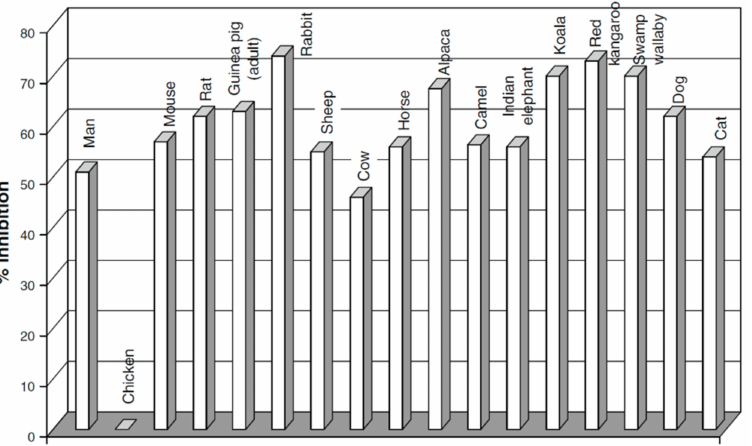
Figure 58. Inhibition of the permeability of RBCs in humans and some laboratory animals and pets for water by PCMBS. Reprinted with permission from [156]. Copyright 2012 Springer